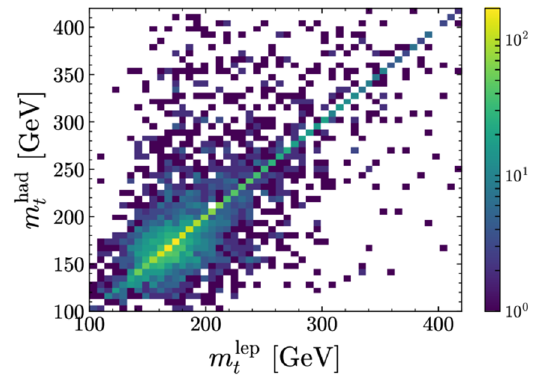
Figure 8 . This (cid:12)gure provides a density plot of the reconstructed top mass for the semi-leptonic channel in the hadronic mass versus the leptonic mass plane. For the underlying simulations, the Monte Carlo truth mass is taken to be m t =172.5 GeV. In the majority of events, the two masses are highly correlated and lie along the diagonal centered around the truth value of m t . This shape motivates the form of the (cid:12)tting function we are proposing that can be used to build a template for extracting the top mass in the semi-leptonic